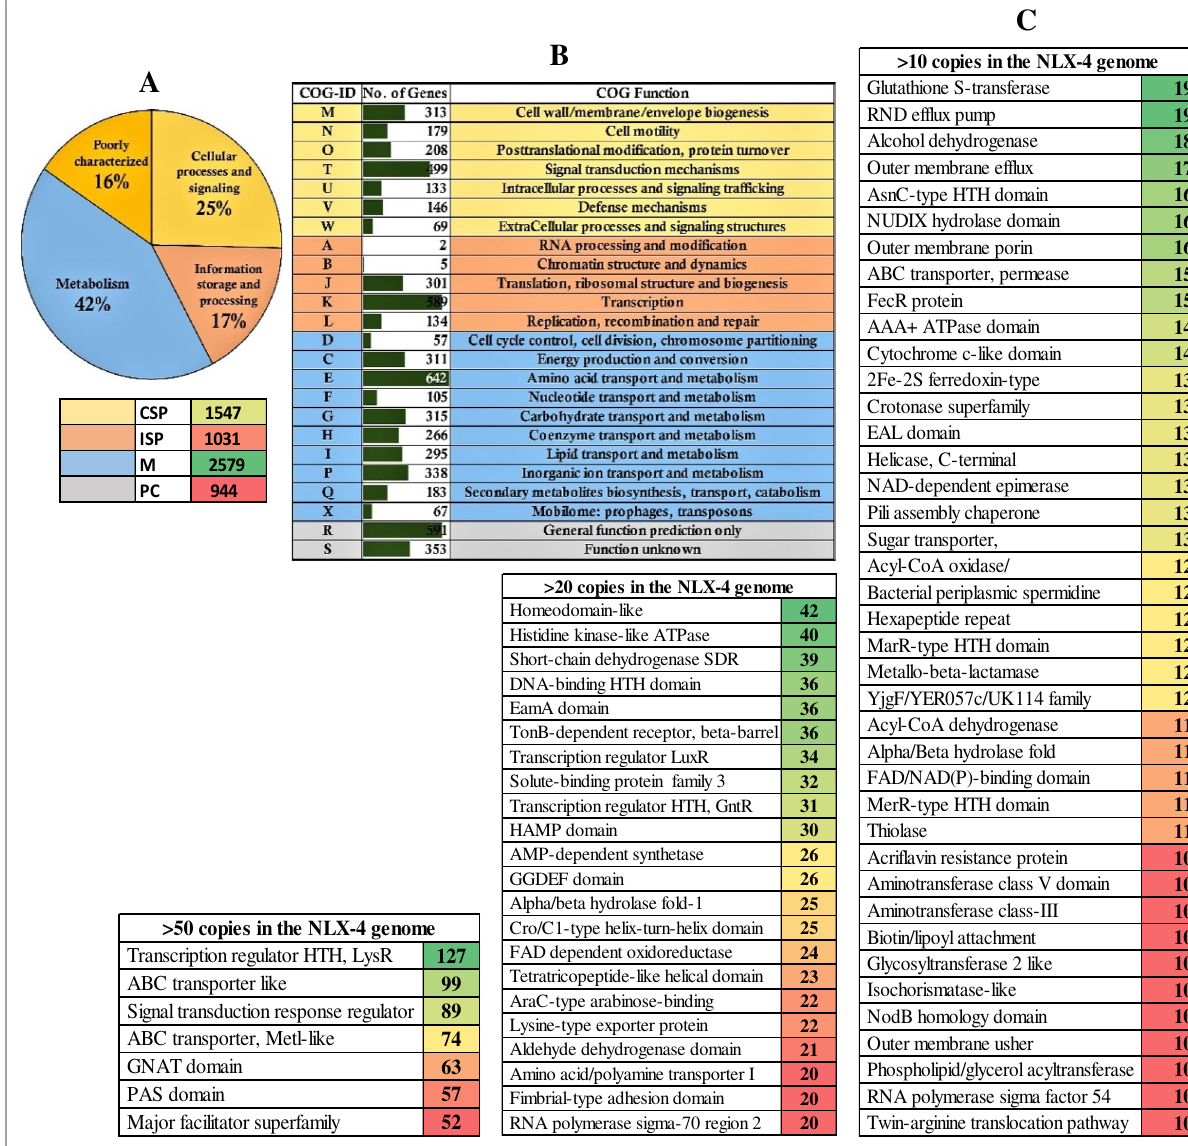
Fig. 2 a Genome-wide distribution of Prokaryotic Orthologous Groups (COG) where CSP: cellular process and signaling 25% (1547); ISP: information storage and processing 17% (1031 genes); M: metabolism 42% (2579 genes); PC: poorly characterized 16% (944 genes). b The listed table illustrates the individual classification of genes in different COG classes which are differentiated based on the color as per pie diagram 2A. c Pictorial illustration of genes occurring > 50 copies, > 20 copies and > 10 copies in the Pseudomonas sp. NLX-4 strain